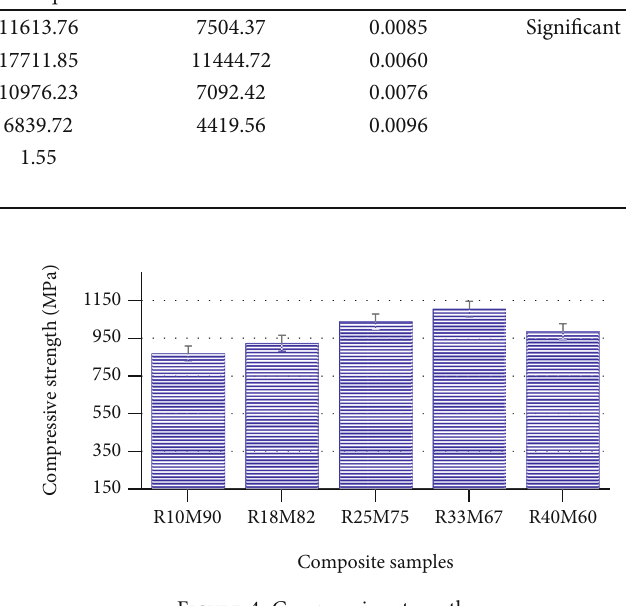
Figure 4: Compressive